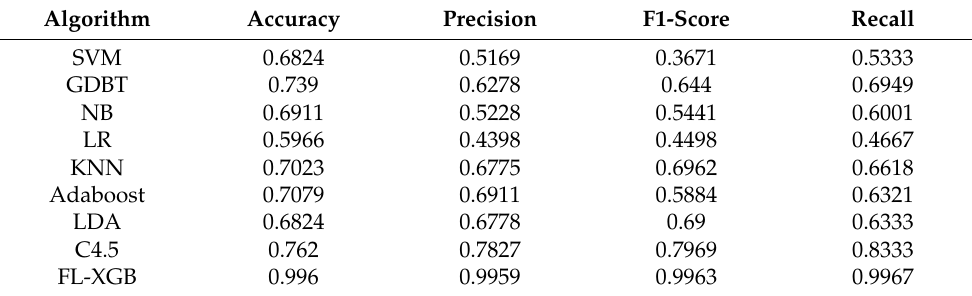
Table 9. Identification results of different algorithms on the ISCXTor2016